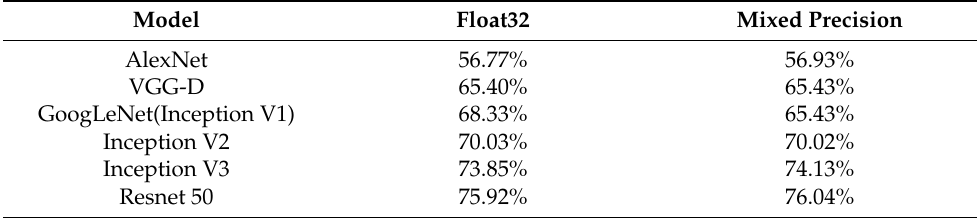
Table 9. ILSVRC12 Classification Top-1